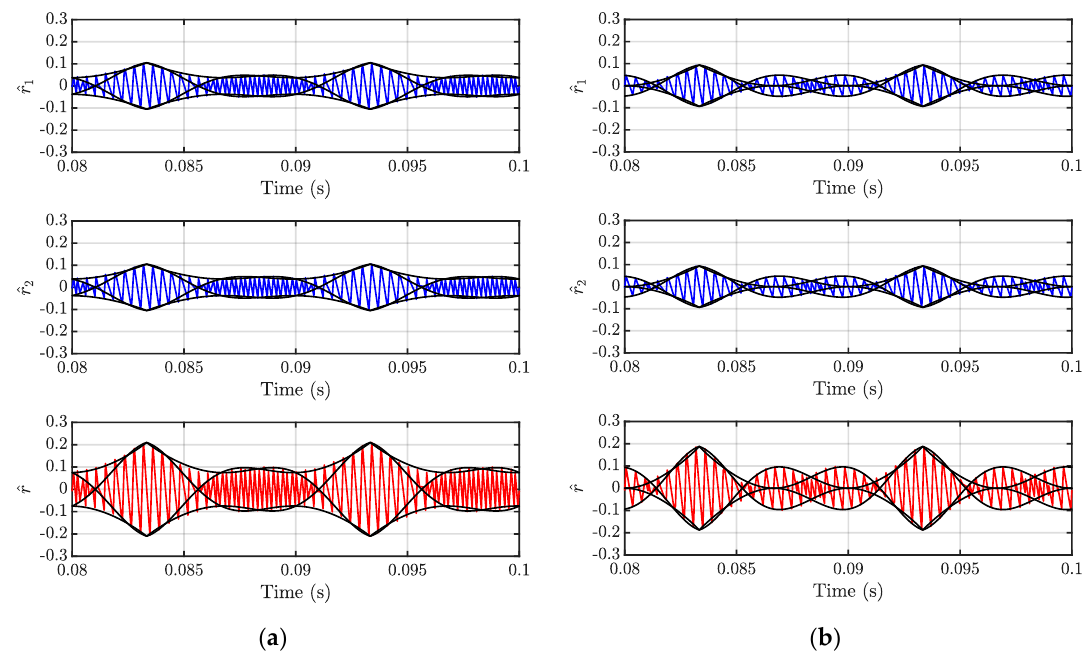
Figure 9. Normalized capacitors switching voltage ripple (ˆ r 1 and ˆ r 2 ) (blue traces), dc-link switching voltage ripple (ˆ r ) (red trace) and calculated envelopes (black traces) over a fundamental period for m = 0.4 ( a ) and m = 0.5 ( b ) in case of ϕ = 0° and unbalanced load (two-phase load). The normalized peak-to-peak dc-link voltage ripple calculated by Equation (25) is shown in Figure 10 within the phase range ϑ = [4π/3, 7π/3].